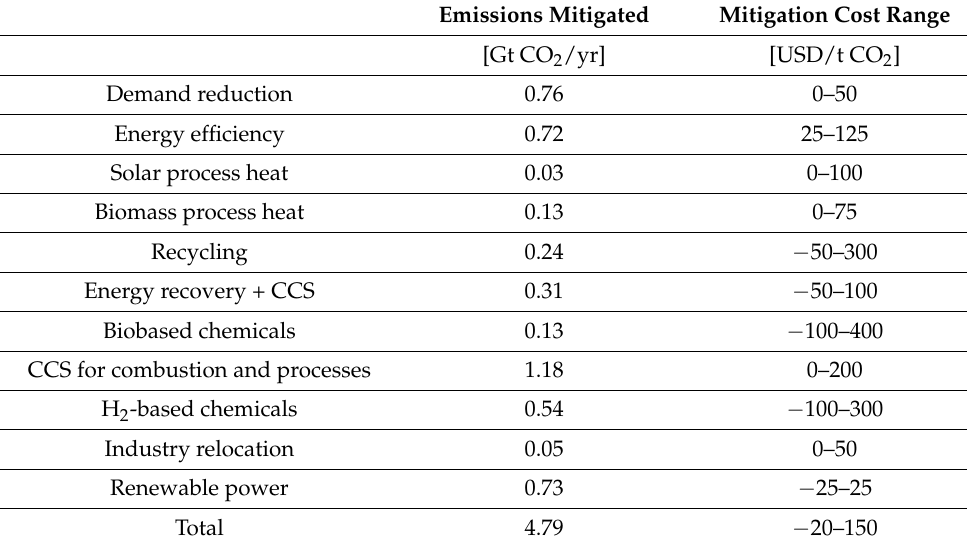
Table 5. Estimated CO 2 mitigation cost in the 1.5 ◦ C case, 2050.